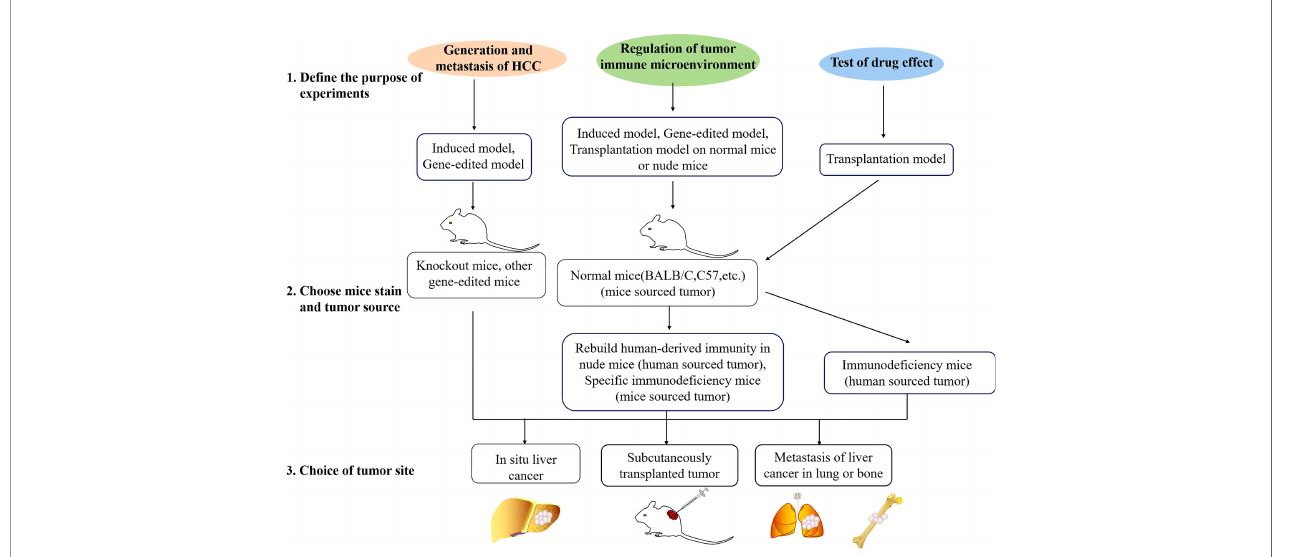
FIGURE 2 | Three steps used to choose a mouse model. Firstly, the purpose of the experiment should be de fi ned. Studies are usually about generation of HCC, immune microenvironment, or drug effect test. Different animal models are available for different experimental purposes. Secondly, the mouse strain and tumor source should be chosen. Depending on different purposes, gene-edited mice, SCID mice, normal mice, and mouse- or patient-derived tissue, human or mouse cell lines could be chosen. Lastly, researchers should choose the tumor site. Most of the time, the subcutaneous model will be chosen in the initial test, and orthotopic or metastasis model will be used in the fi nal